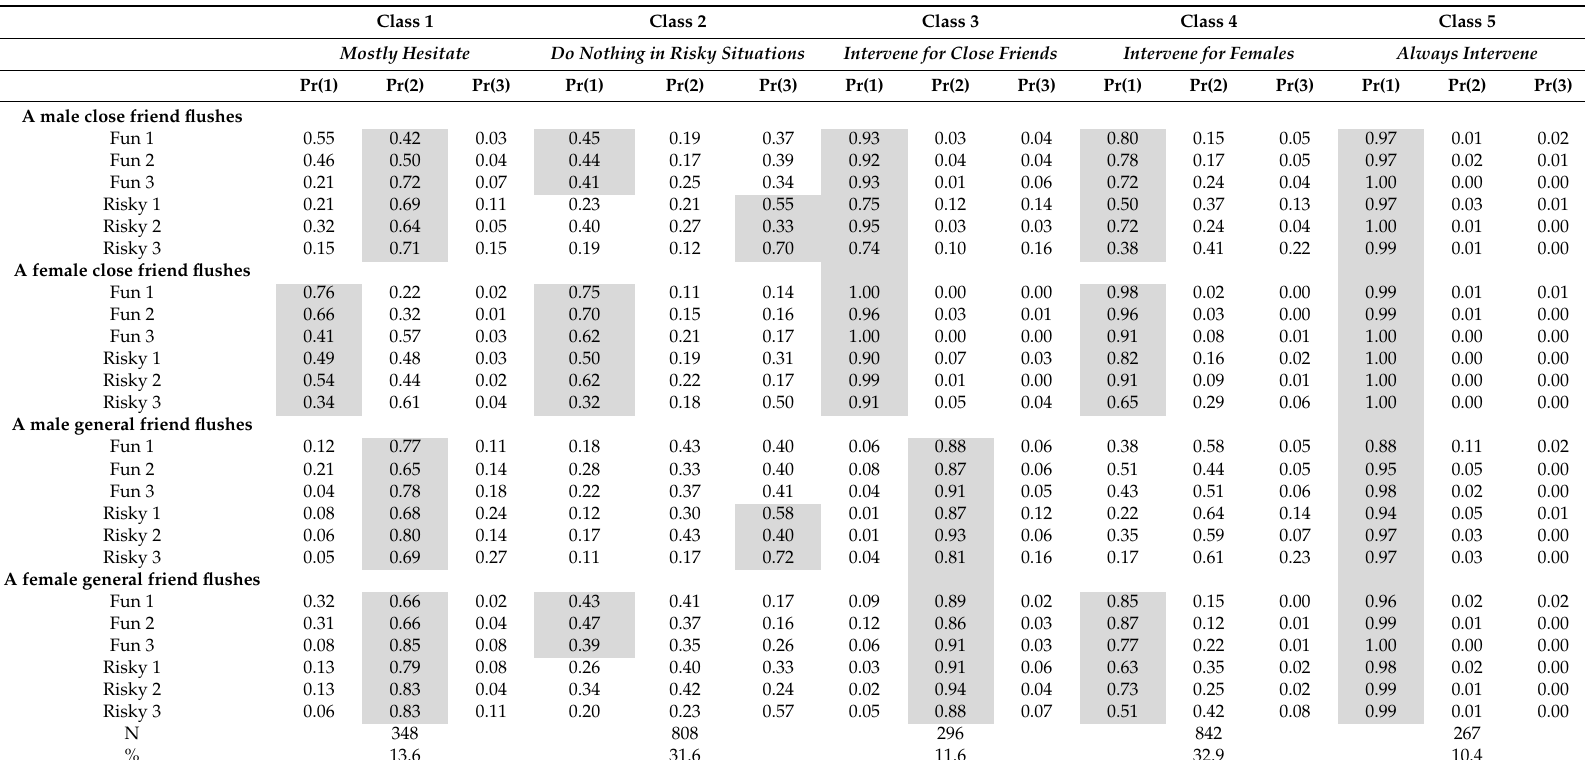
Table A1. Conditional Item-Response